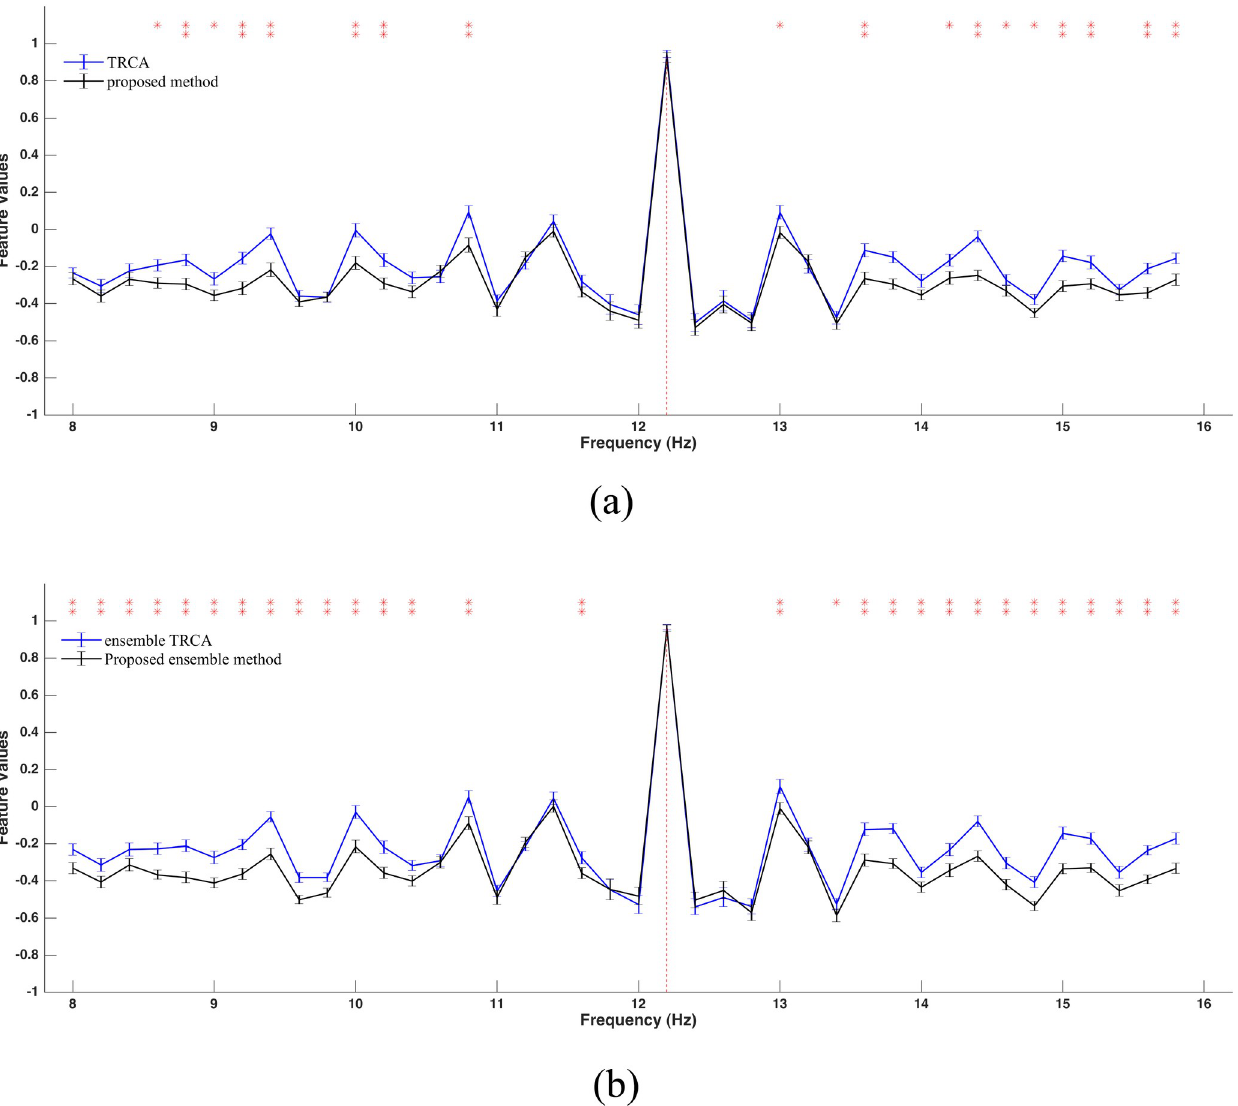
Fig 7. An example of normalized feature values, averaged across subjects and blocks, obtained by: (a) two basic methods; and (b) two ensemble methods. Red vertical line indicates true frequency. Data length is 0.6 s. Asterisks represent a significant difference between the two methods by paired t- tests ( � p < 0.01, �� p < 0.001). Error bars show standard